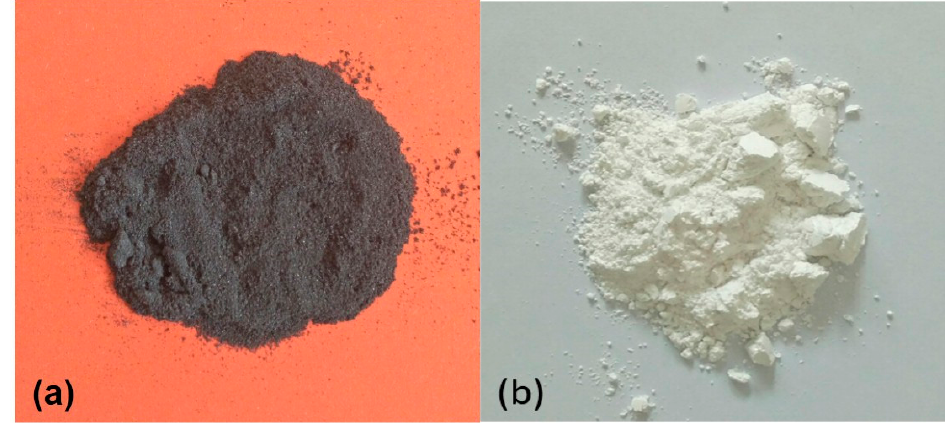
Figure 5. Sample photographs of: ( a ) Graphene nanoplatelets; ( b ) MgO Figure 5 . Sample photographs of: ( a ) Graphene nanoplatelets; ( b ) MgO NPs .